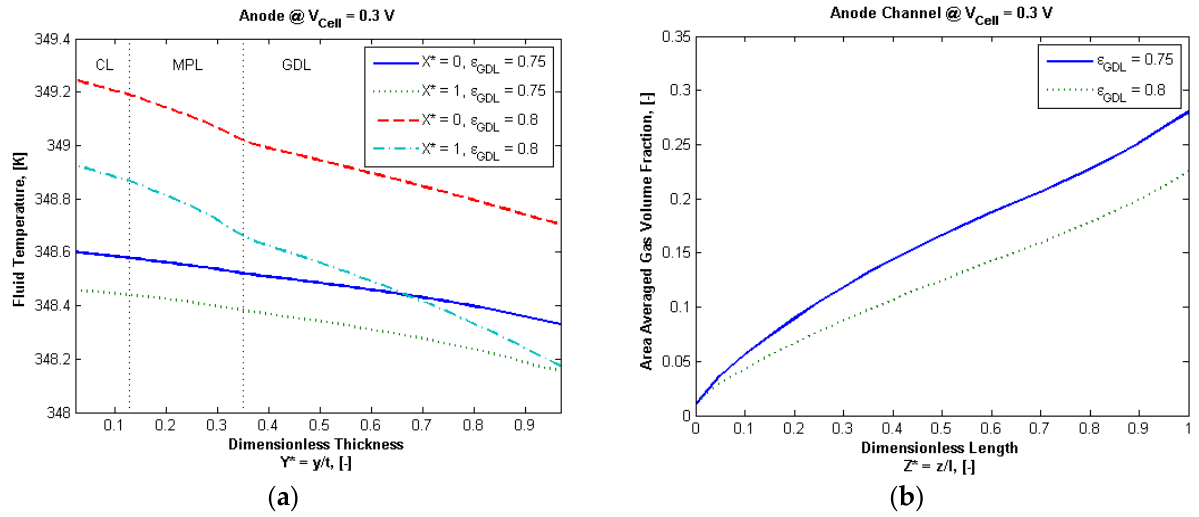
Figure 6. ( a ) The area-averaged liquid saturation distribution along the anode channel for two cases of GDL porosity at a cell voltage 0.3 V; ( b ) fluid temperature concentration distribution in the anode electrode for two cases of GDL porosity at cell voltage 0.3 V.